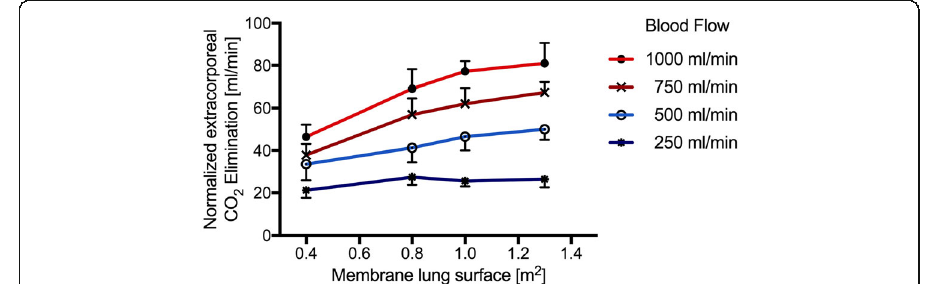
Fig. 3 Normalized extracorporeal elimination of carbon dioxide (CO 2 ) depending on membrane lung surface. Normalized CO 2 removal was calculated by normalizing the partial pressure of carbon dioxide before the membrane lung to 45 mmHg. The normalized extracorporeal CO 2 elimination was plotted against membrane lung surface. Blood flow was titrated from 250 to 1000 ml/min. Each data point represents the mean and standard deviation of seven pigs